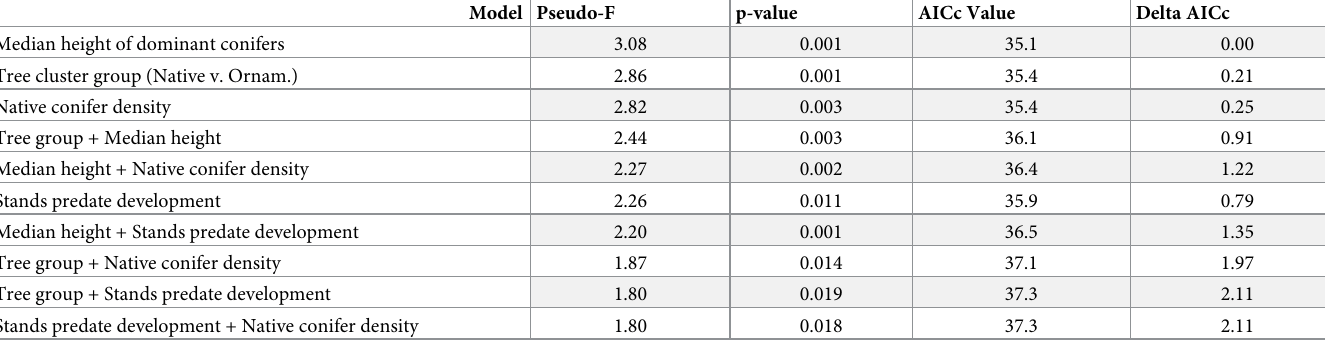
Table 5. PERMANOVA model summary comparing multivariate models of shrub community